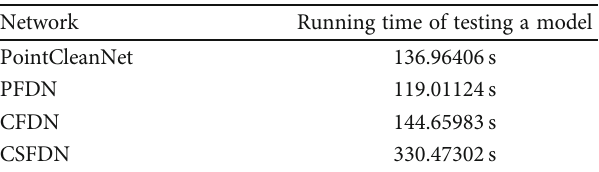
Table 5: Quantitative comparison of test time, the noisy point cloud of casing contains 25,952